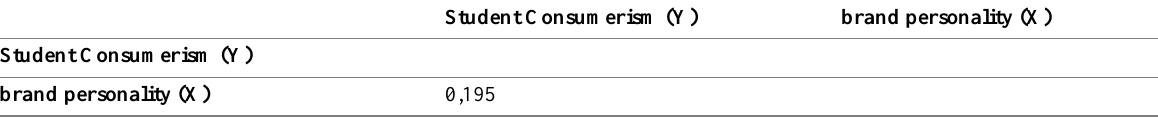
Table 3 : Heterotrait-Monotrait Ratio